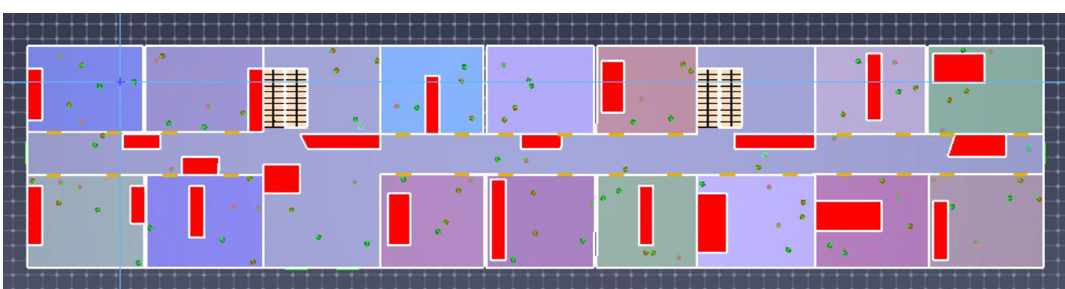
Figure 15. Obstacle setup in Pathfinder emergency evacuation